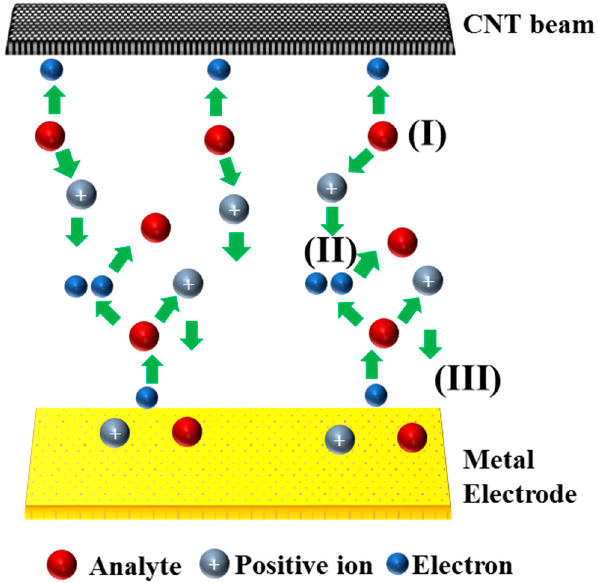
Figure 7. Sensing mechanism with a positive nanotip: (I) Nanotip Ionization, (II) Impact Ionization, and (III) Electron Recombination.